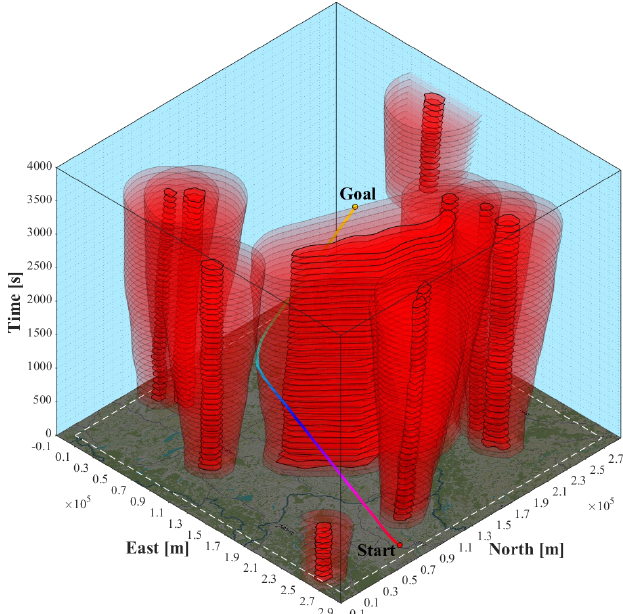
Figure 10. Near-optimal anticipatory avoidance trajectory based on 19:05 h